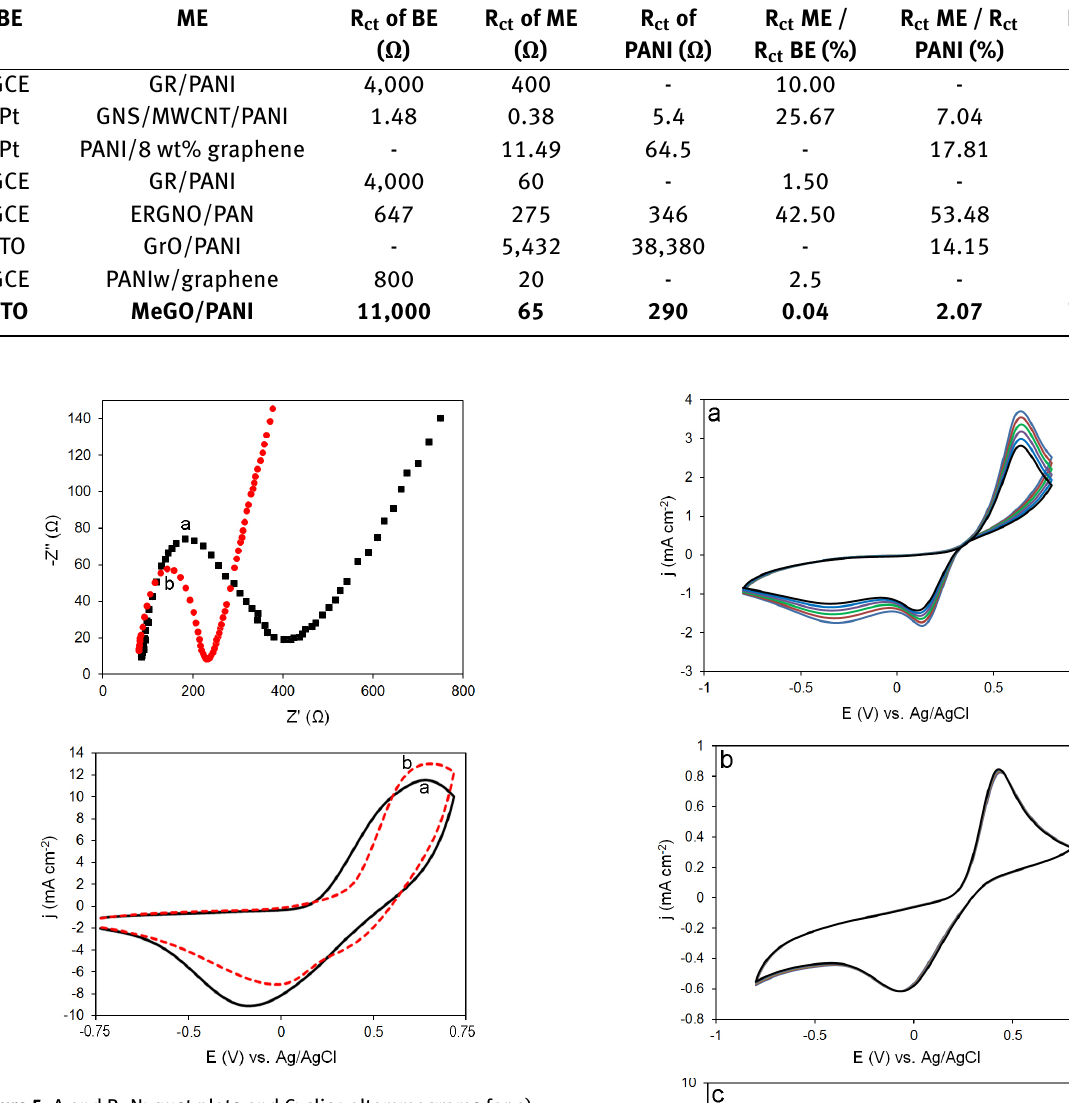
Figure 5: A and B: Nyqust plots and Cyclic voltammograms for a) PANI, and b) MeGO/PANI on the FTO surface in 5 mM K3Fe(CN)6 and 0.01 M PBS